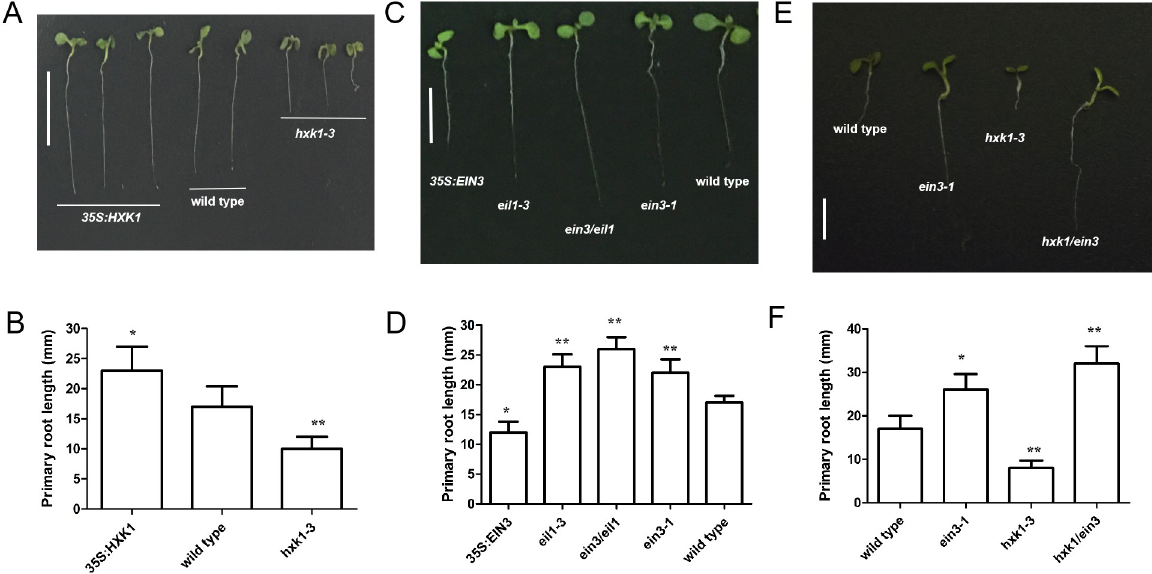
Fig 1. HXK1 is upstream of EIN3/EIL1 to positively regulate primary root growth. A , The image illustrating 5-day-old Arabidopsis 35S : HXK1 , wild-type and hxk1-3 seedlings grown on MS medium with 1% glucose. Bar = 1.0 cm. B , Bar graph illustrating the differences in primary root length in (A). C , The image illustrating 5-day-old 35S : EIN3 , eil1-3 , ein3/eil1 , ein3-1 and wild-type seedlings grown on MS medium with 1% glucose. Bar = 1.0 cm. D , Bar graph illustrating the differences in primary root length in (C). E , The image illustrating 5-day-old hxk1-3 , ein3-1 and hxk1/ein3 seedlings grown on MS medium with 1% glucose. Bar = 1.0 cm. F , Bar graph illustrating the differences in primary root length in (E). Error bars represent SD (n = 12). Student’s t test ( �� P < 0.01; � P < 0.05).